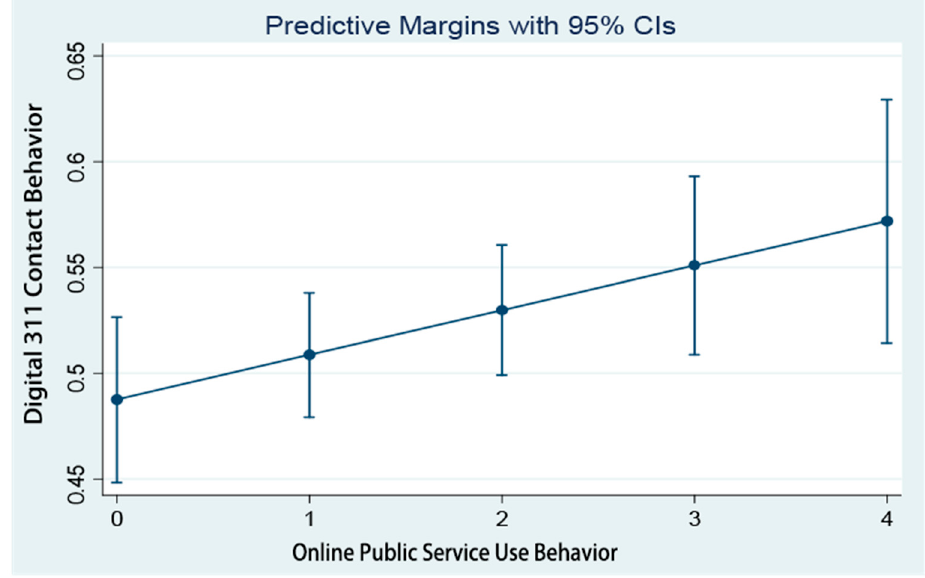
Figure 1. Estimated probabilities of digital 311 contact behavior caused by online public service use behavior.